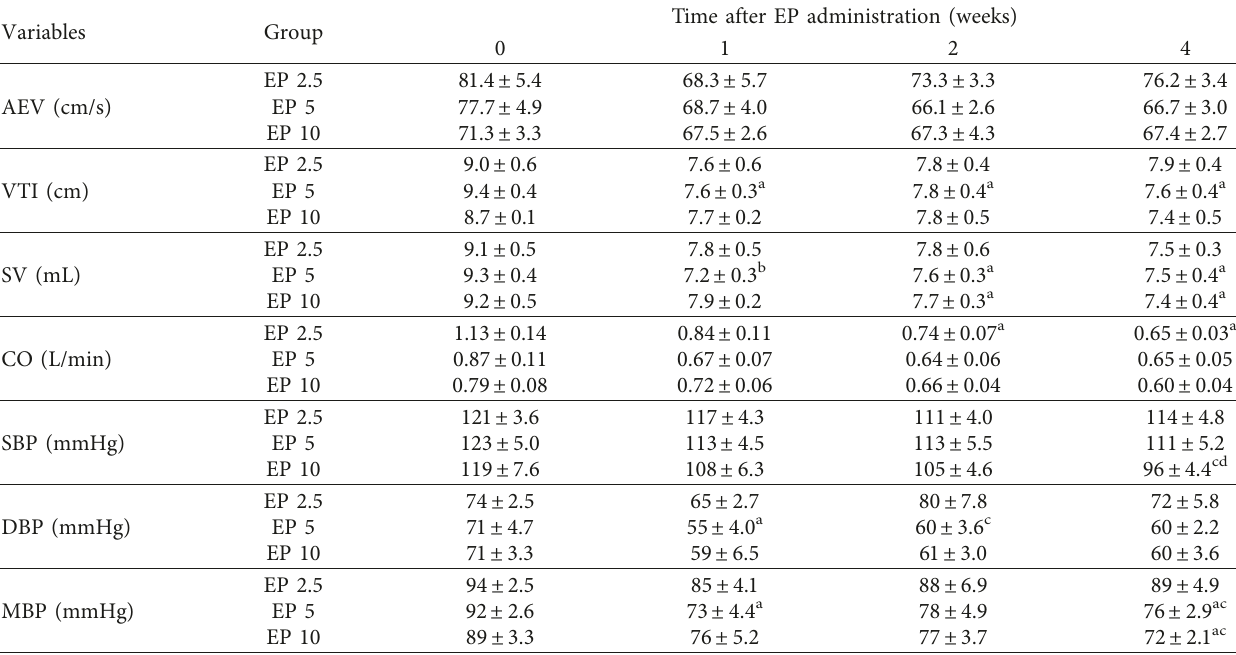
Each value represents the mean ± standard error ( n � 5). EP 2.5, 5, and 10: eplerenone 2.5, 5, and 10mg/kg, respectively. a Value differs significantly from the baseline (time 0) value at P < 0 . 05. Table 3: Aortic ejection flow velocity (AEV), velocity time integral (VTI), stroke volume (SV), cardiac output (CO), systolic blood pressure (SBP), diastolic blood pressure (DBP), and mean blood pressure (MBP) values after eplerenone (EP) administration in dogs.